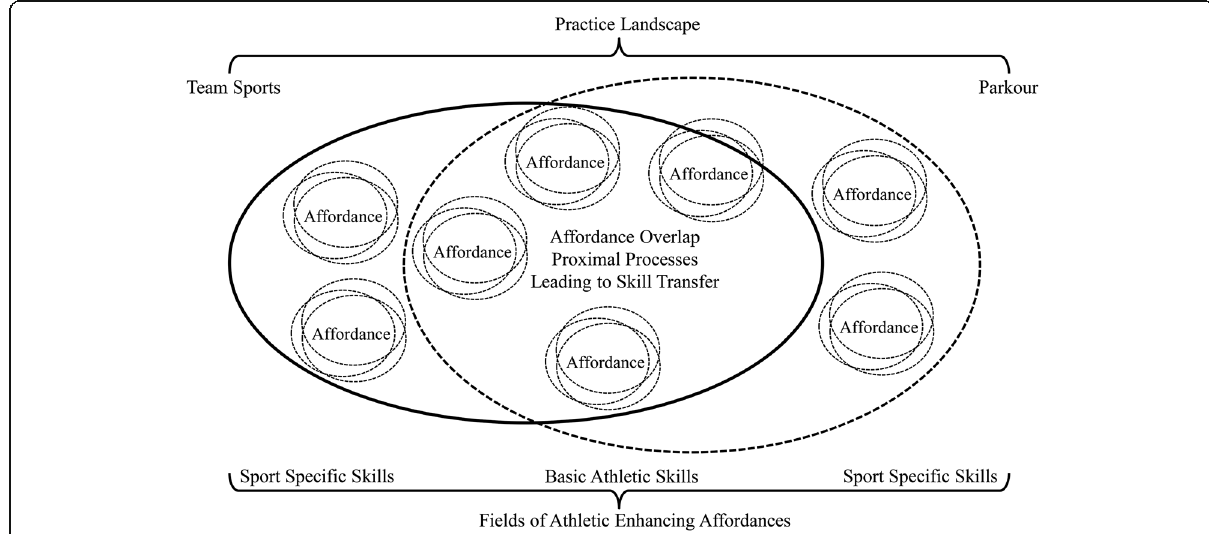
Fig. 1 Overlap of performance-enhancing affordance fields between team sports and parkour as a donor